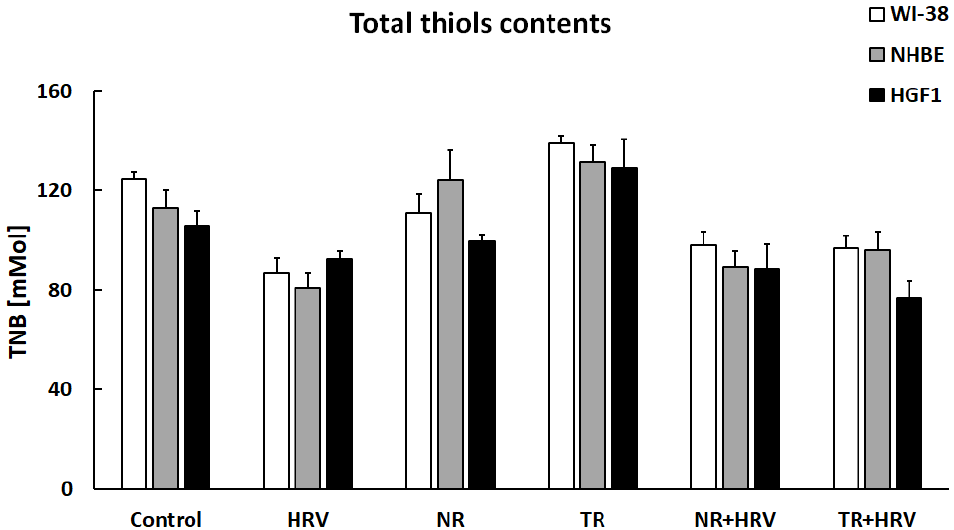
Figure 5. Expression of MCAF in mRNA ( A ) and protein ( B ) levels after treatment with (NR) and (TR) Leonotis nepetifolia root extracts. Data presented as mean ± SEM, * p < 0.05.